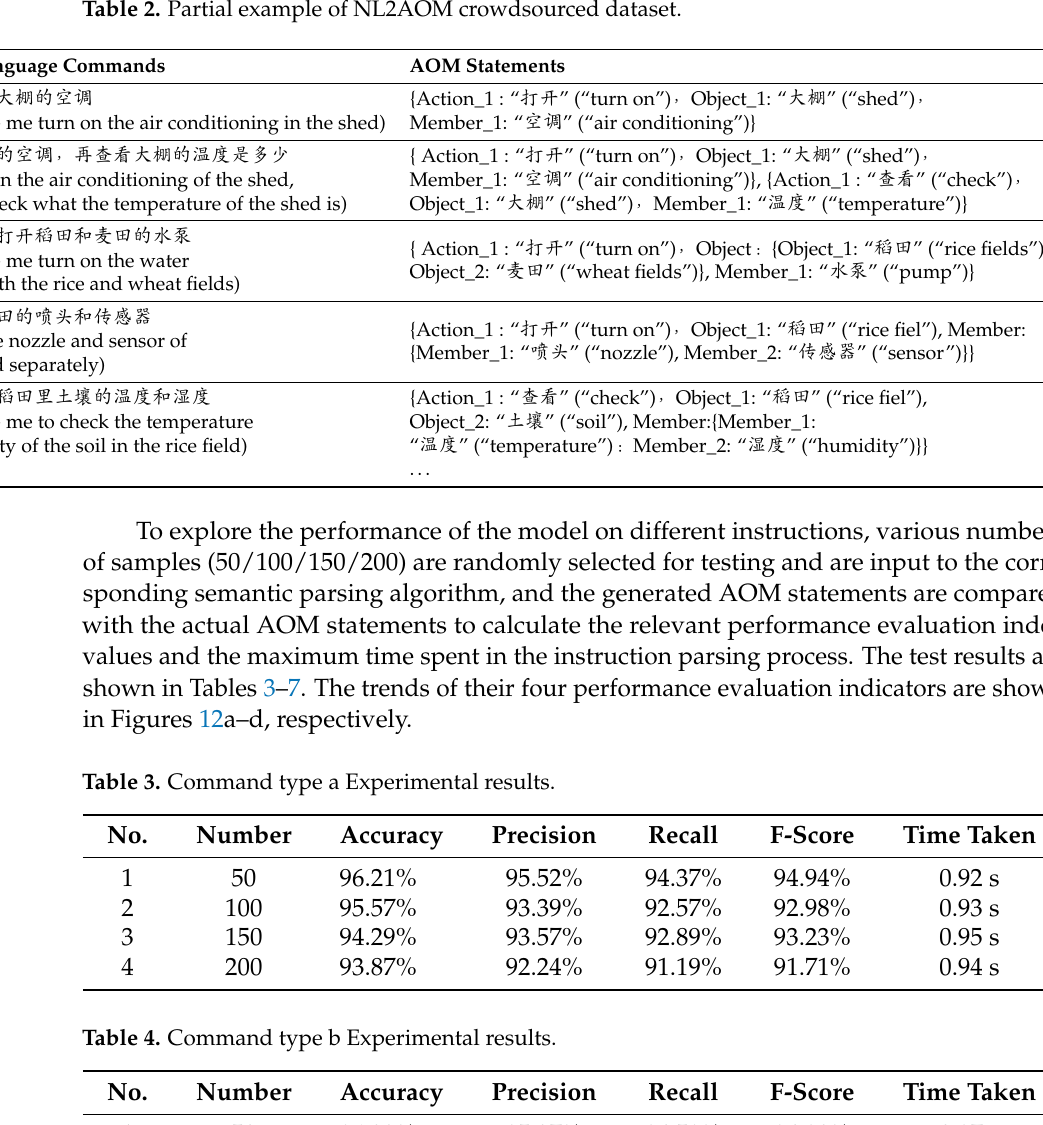
Table 2. Partial example of NL2AOM crowdsourced dataset.